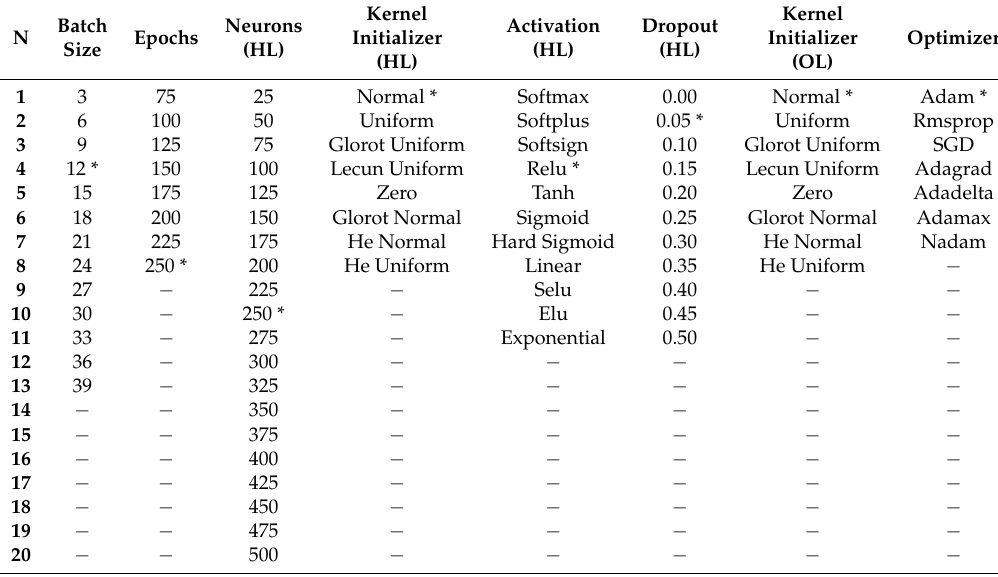
Table A4. Gridsearch/Randomsearch search range (* = default